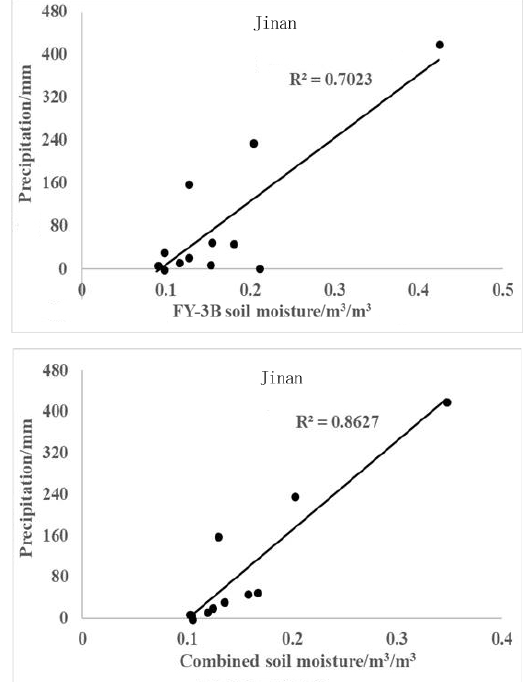
Fig.3 correlation analysis between measured precipitation